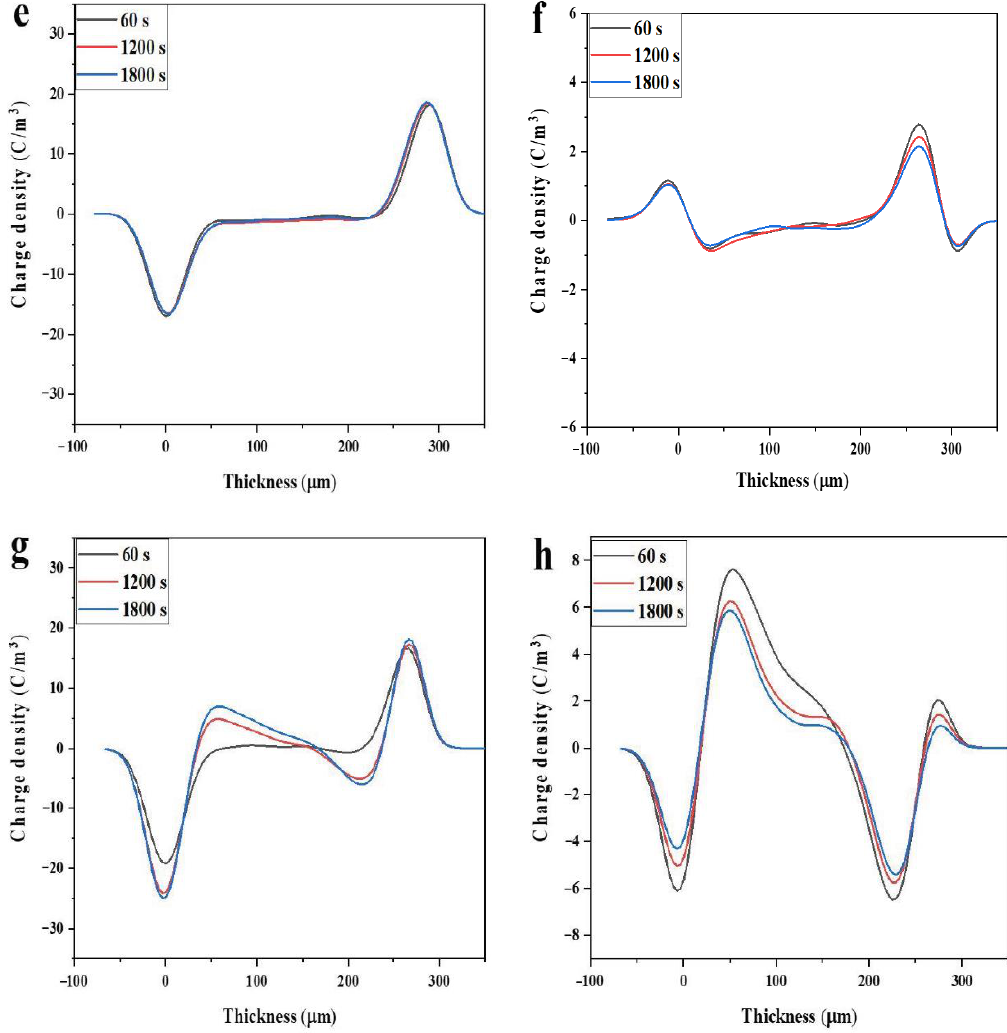
Figure 8. Space charge distribution ( a ) PP, ( c ) SEBS/PP, ( e ) 4.6% Ac-SEBS/PP, ( g ) 12% Ac-SEBS/PP and short circuit conditions ( b ) PP, ( d ) SEBS/PP, ( f ) 4.6% Ac-SEBS/PP, ( h ) 12% Ac-SEBS/PP.